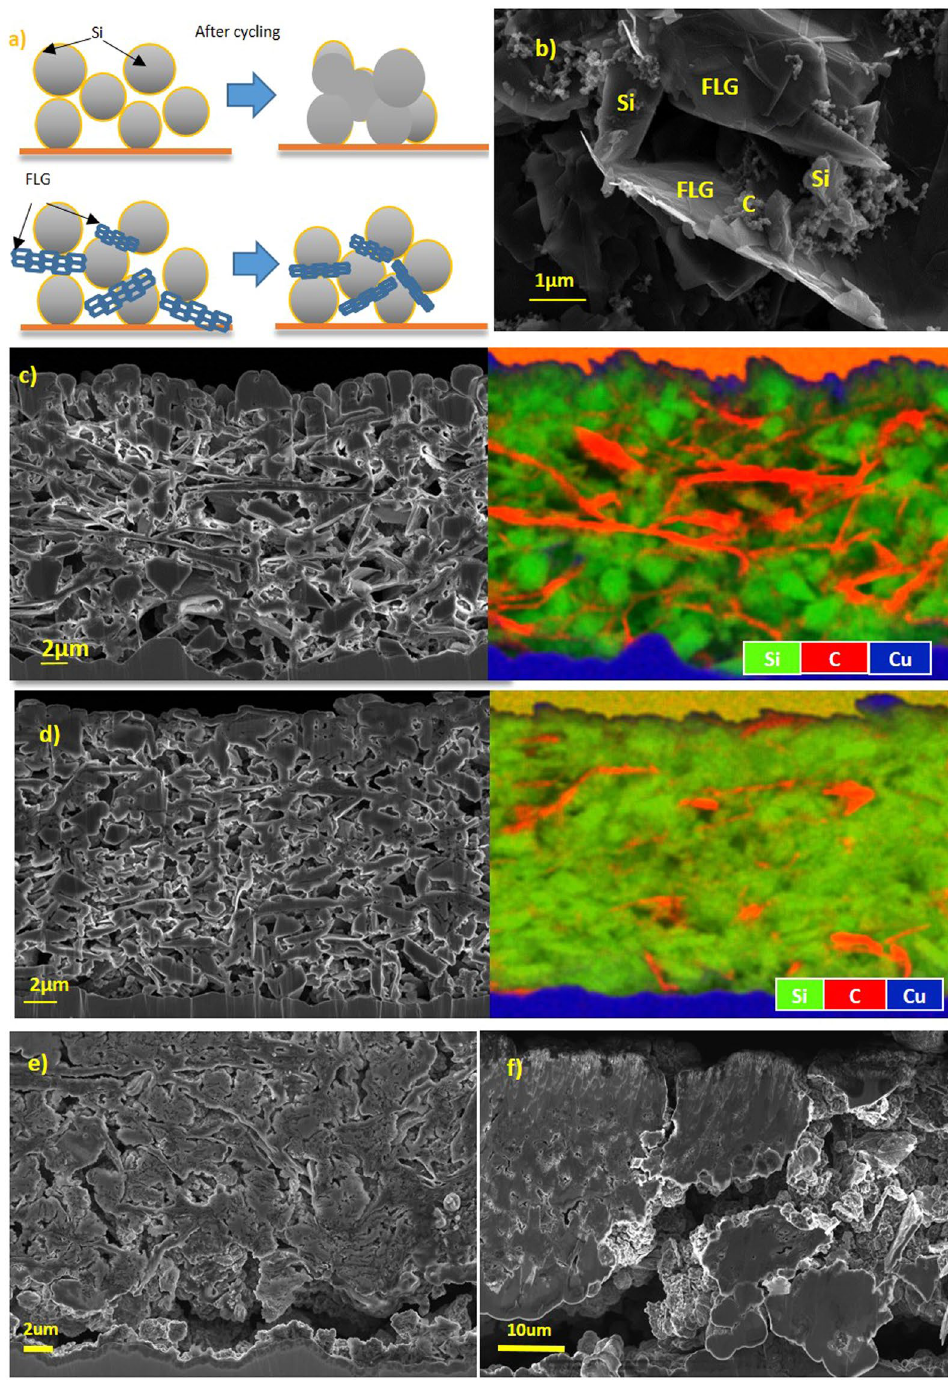
Figure 1. ( a ) Schematic of FLG preventing Si electrochemically “fused” together; ( b ) SEM image for Si-FLG electrode (60% Si: 16%FLG: 14% Na-PAA: 10% Carbon mix); ( c ) Cross-section image and EDS mapping for Si-FLG composite electrode; ( d ) Cross-section image and EDS mapping for Si only electrode; ( e ) Cross-section image for Si-FLG electrode after 100 cycles and ( f ) Cross-section image for Si only electrode after 100